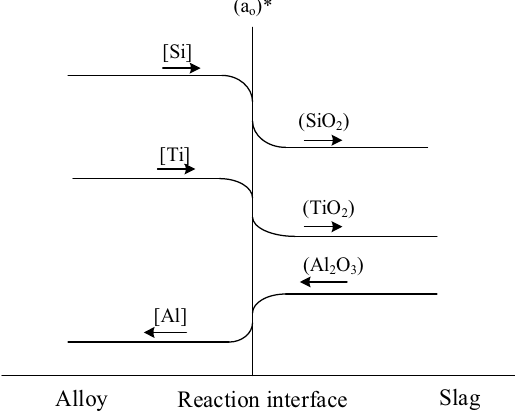
Figure 1: Mass transfer diagram of the slag – metal interface ( a O⁎ is the oxygen activity at the interface )